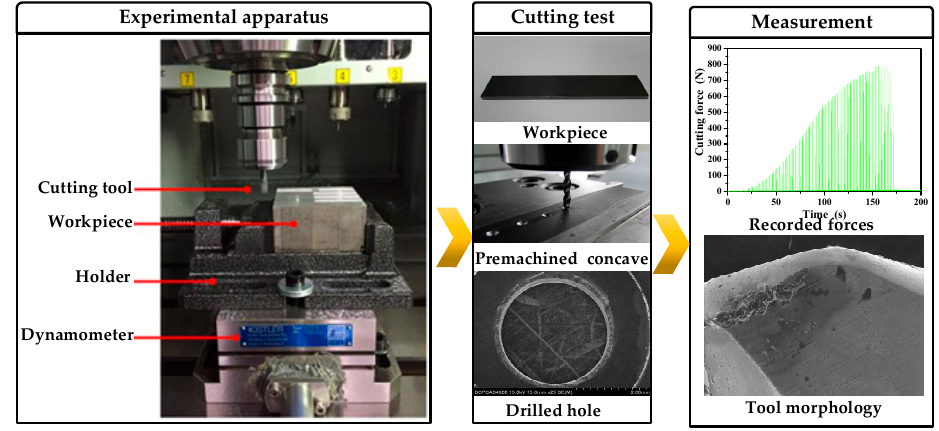
Figure 2. Experimental setup.